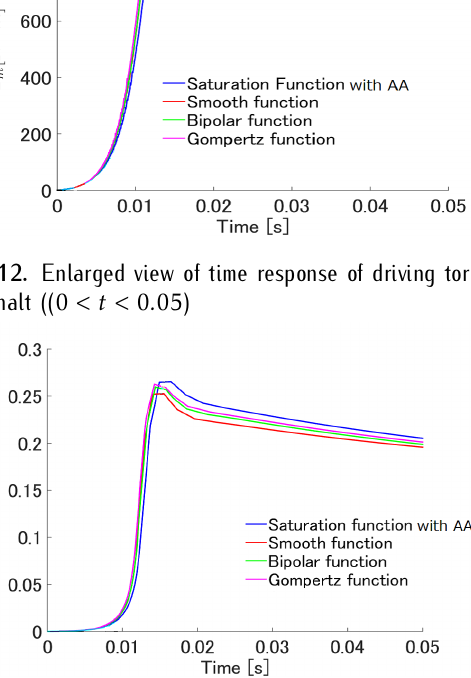
Figure 17. Enlarged view of time response of slip ratio on wet asphalt (( 0 < t < 0 : 05